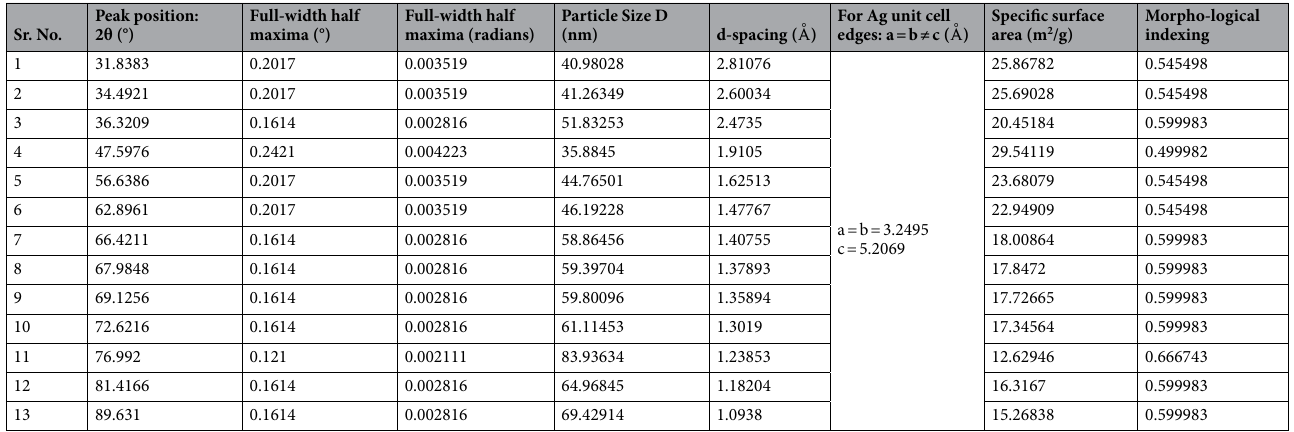
Table 2. XRD analysis and calculation of various parameters for ZnO